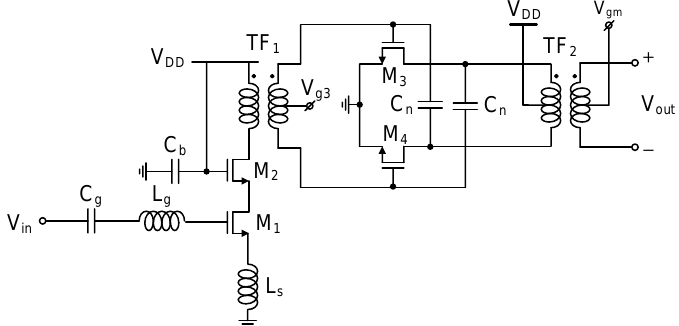
Figure 8. Low-noise amplifier (LNA).